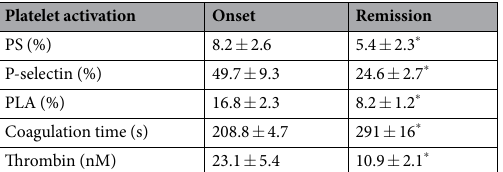
Table 3. Platelet activation in patients during and after sepsis. Values given in mean and SD. * P < 0.05